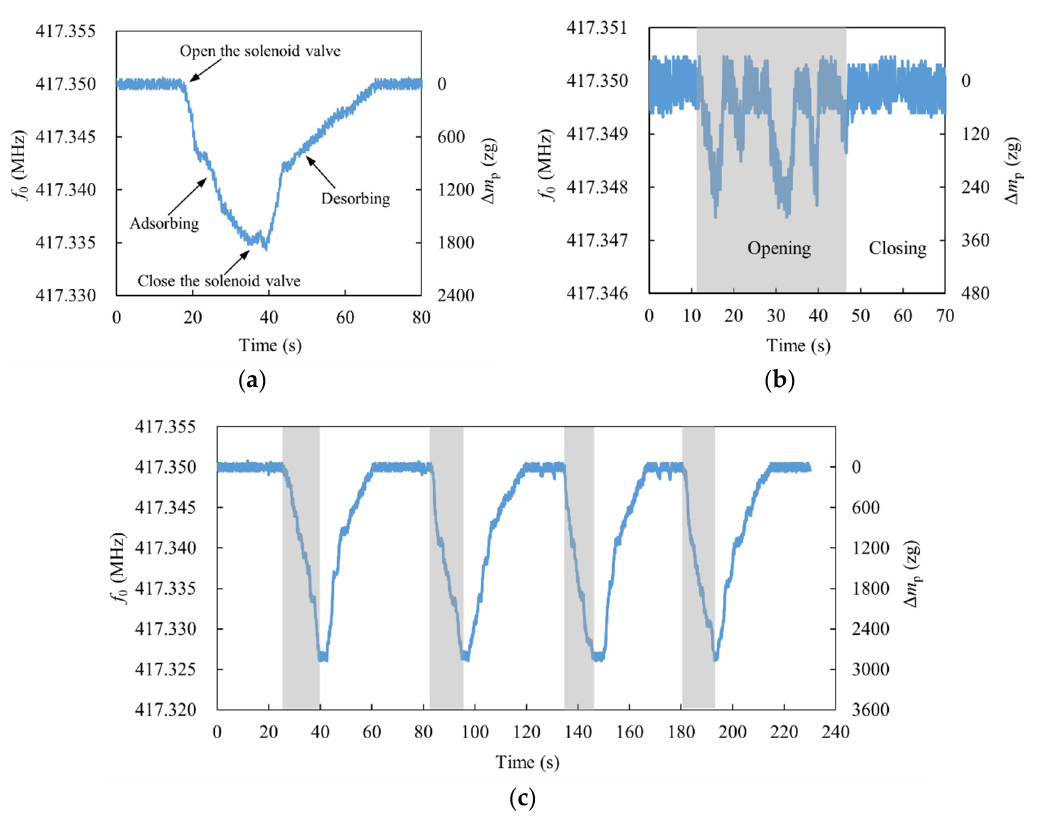
Figure 7. Effect of l nd on the sensor response: ( a ) l nd = 5 mm; ( b ) l nd = 15 mm; ( c ) l nd = 3 mm.